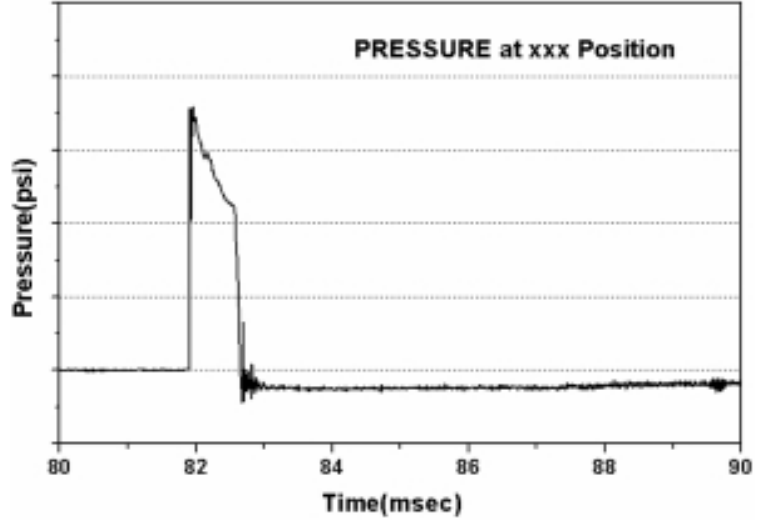
Fig. 7. Shock pressure profile at outside hull.